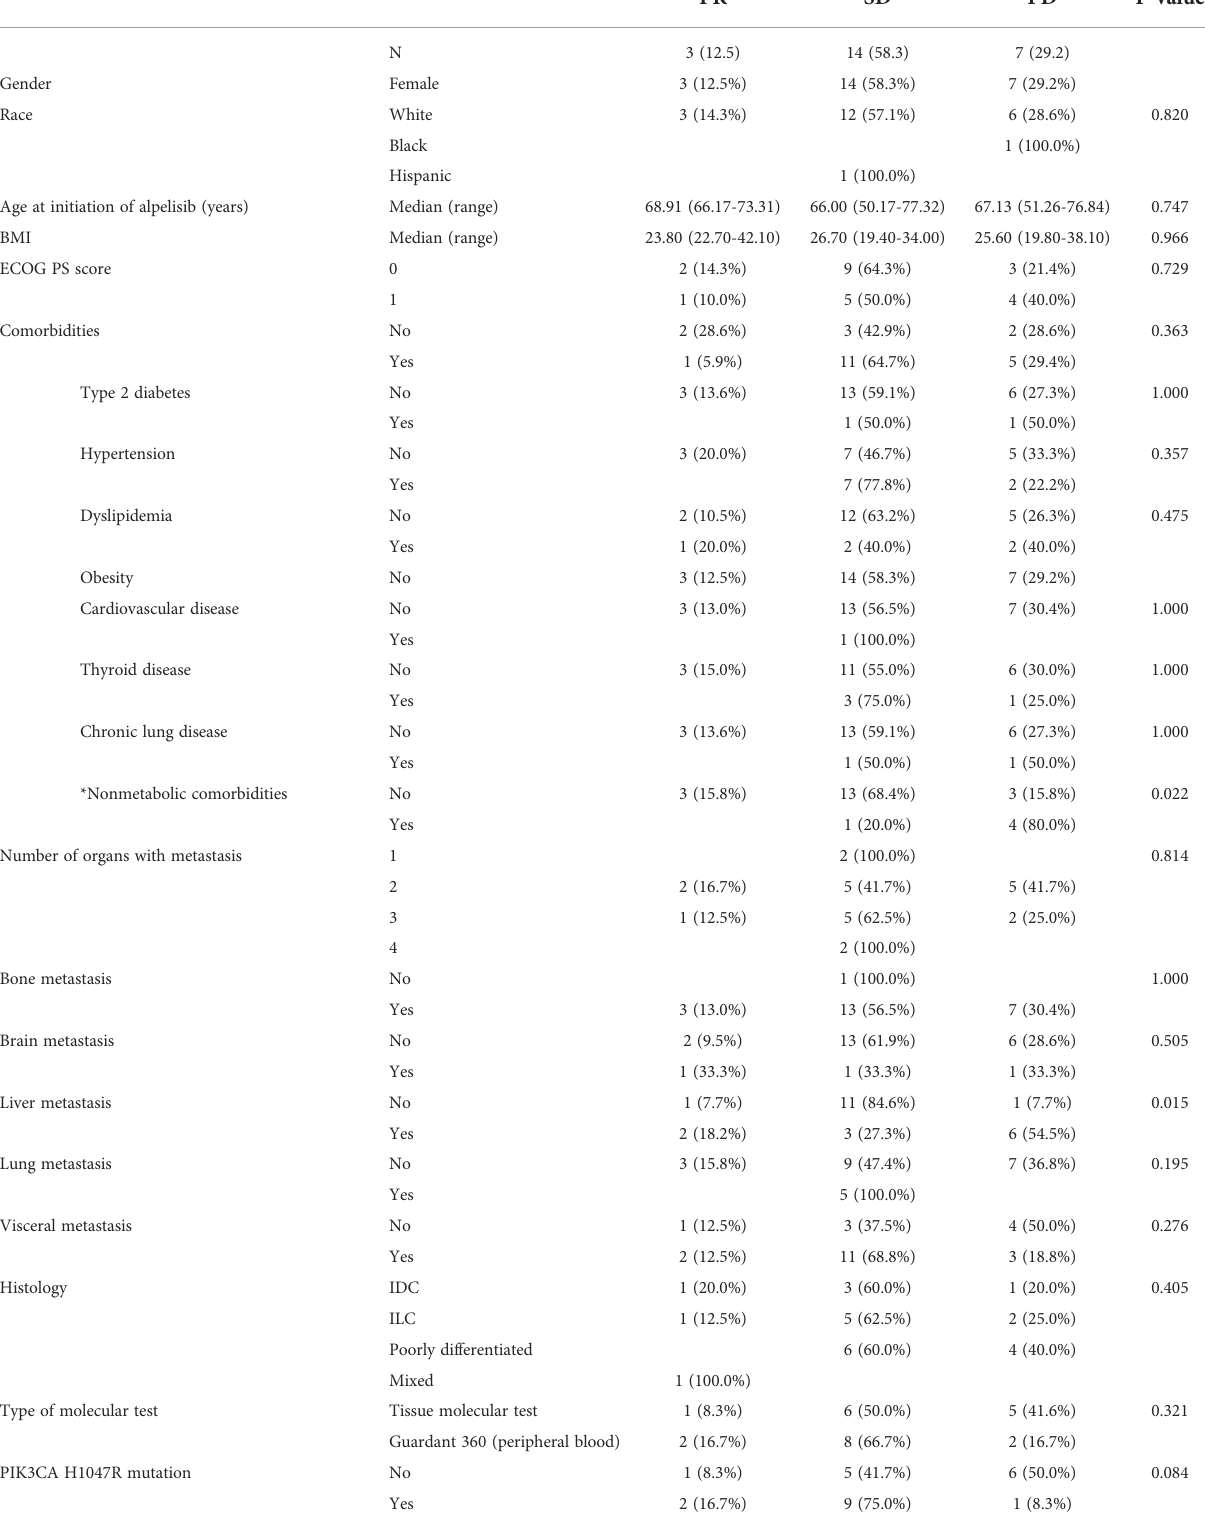
TABLE 5 Association of clinical/demographic characteristics with best response to